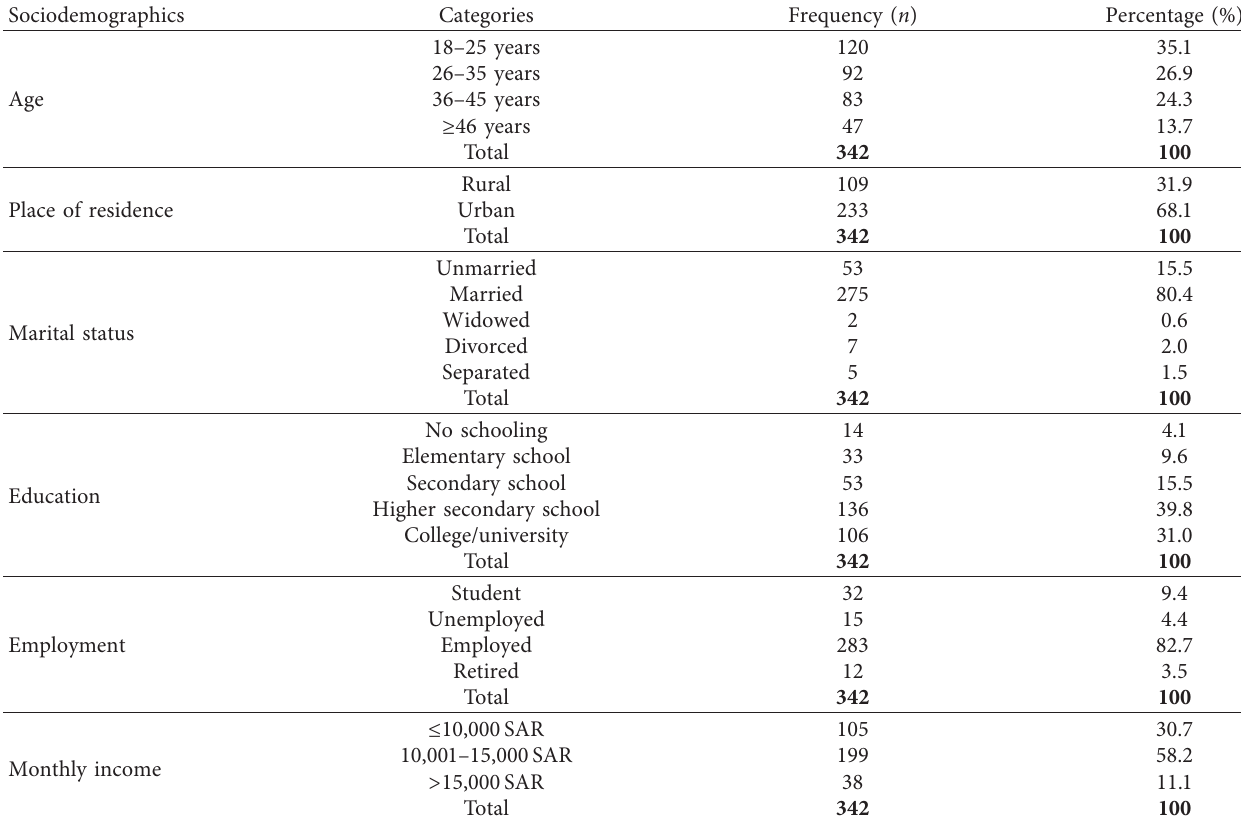
Table 1: Sociodemographic characteristics of the study participants ( n � 342).